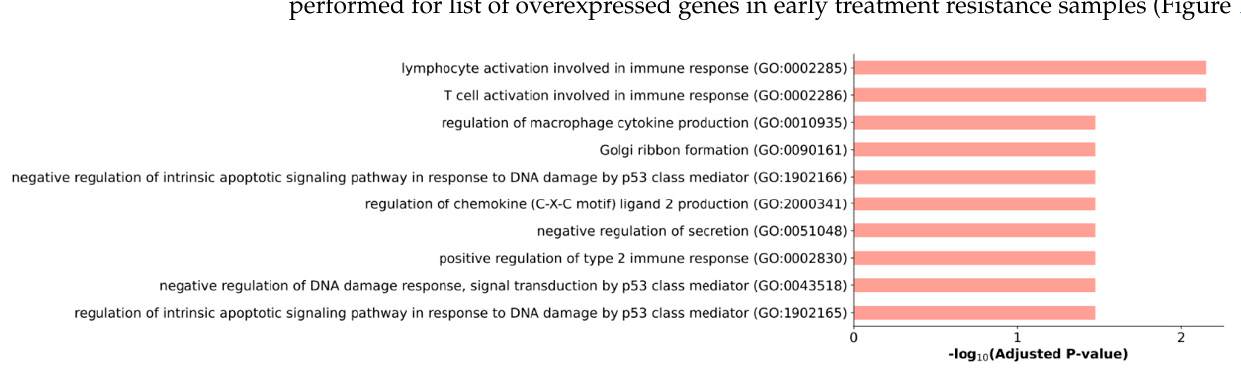
Figure 1. Biological processes involving DE genes in blood plasma exosomes of patients with CRPC during progression of docetaxel therapy. The distribution of pathways is plotted against the level of static significance ( − log10 adjusted p -value).